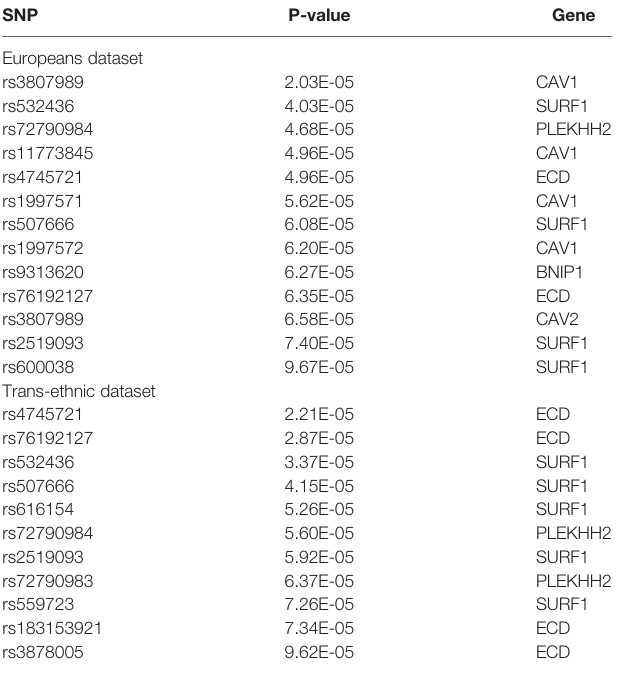
TABLE 3 | SMR results of cardioembolic stroke.